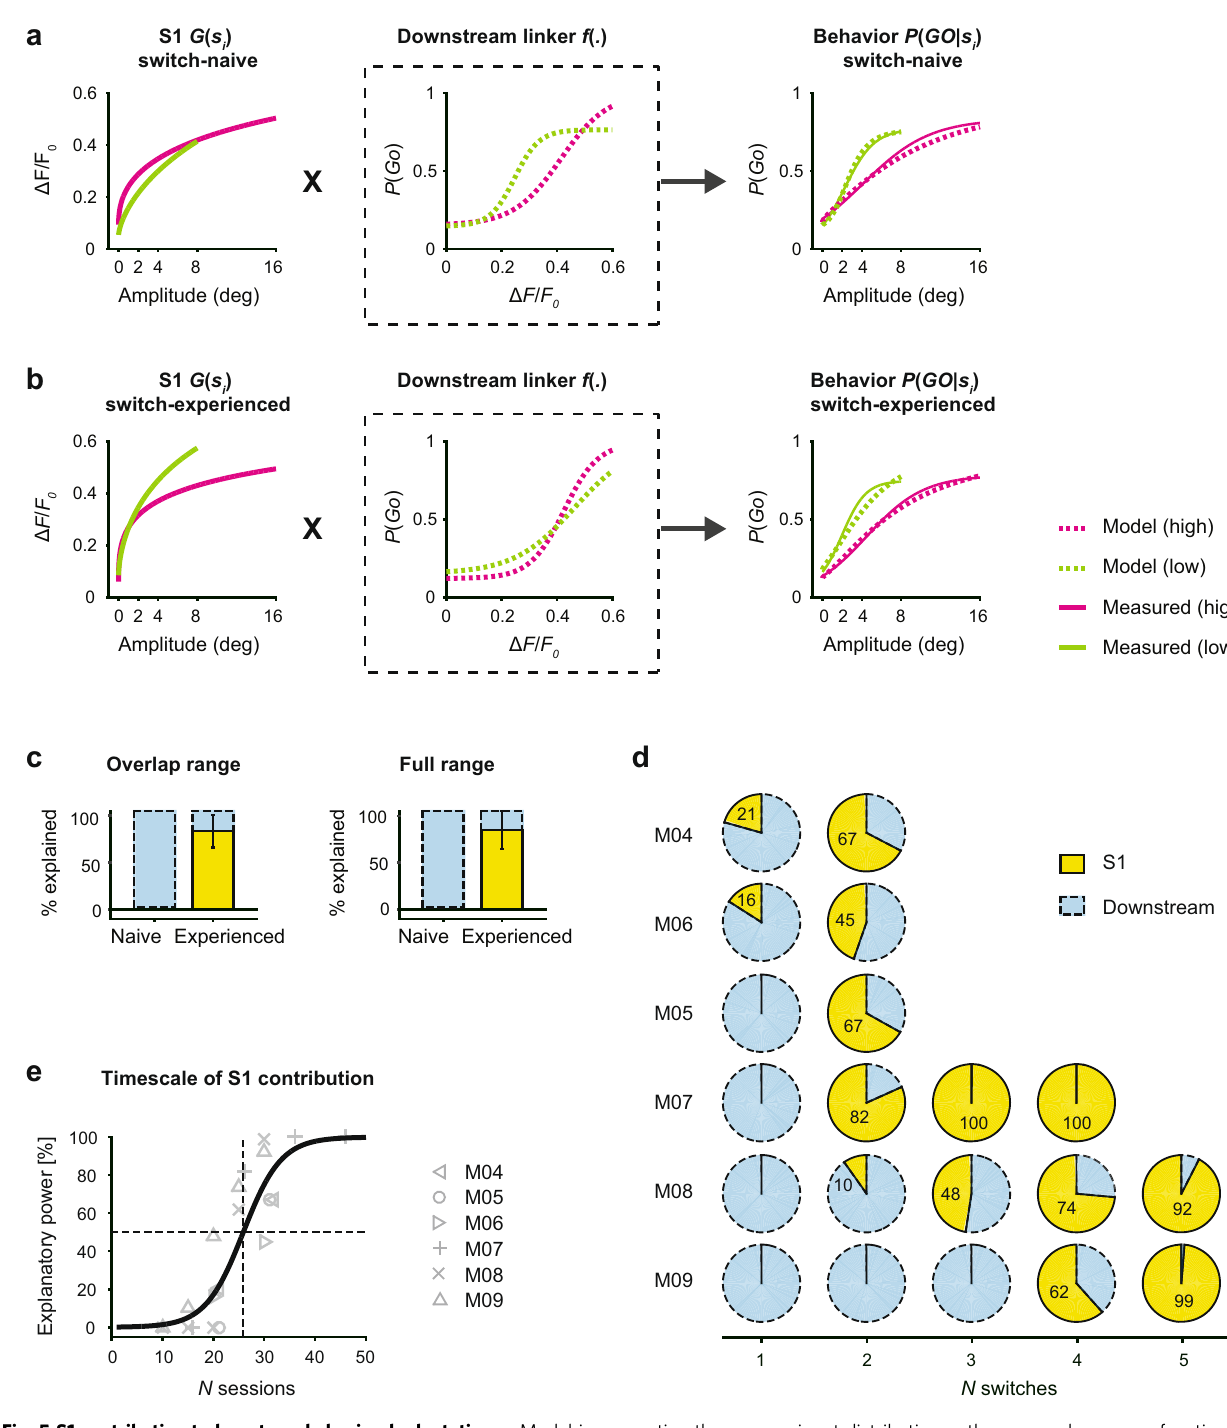
Fig. 5 S1 contribution to long-term behavioral adaptation. a Model incorporating the sensory input distribution s i , the neuronal response function G ( s i ) derived from the GEVI signal in S1, and the behavioral readout P ( GO │ s i ). The function f (.) represents a downstream process, matching the evoked